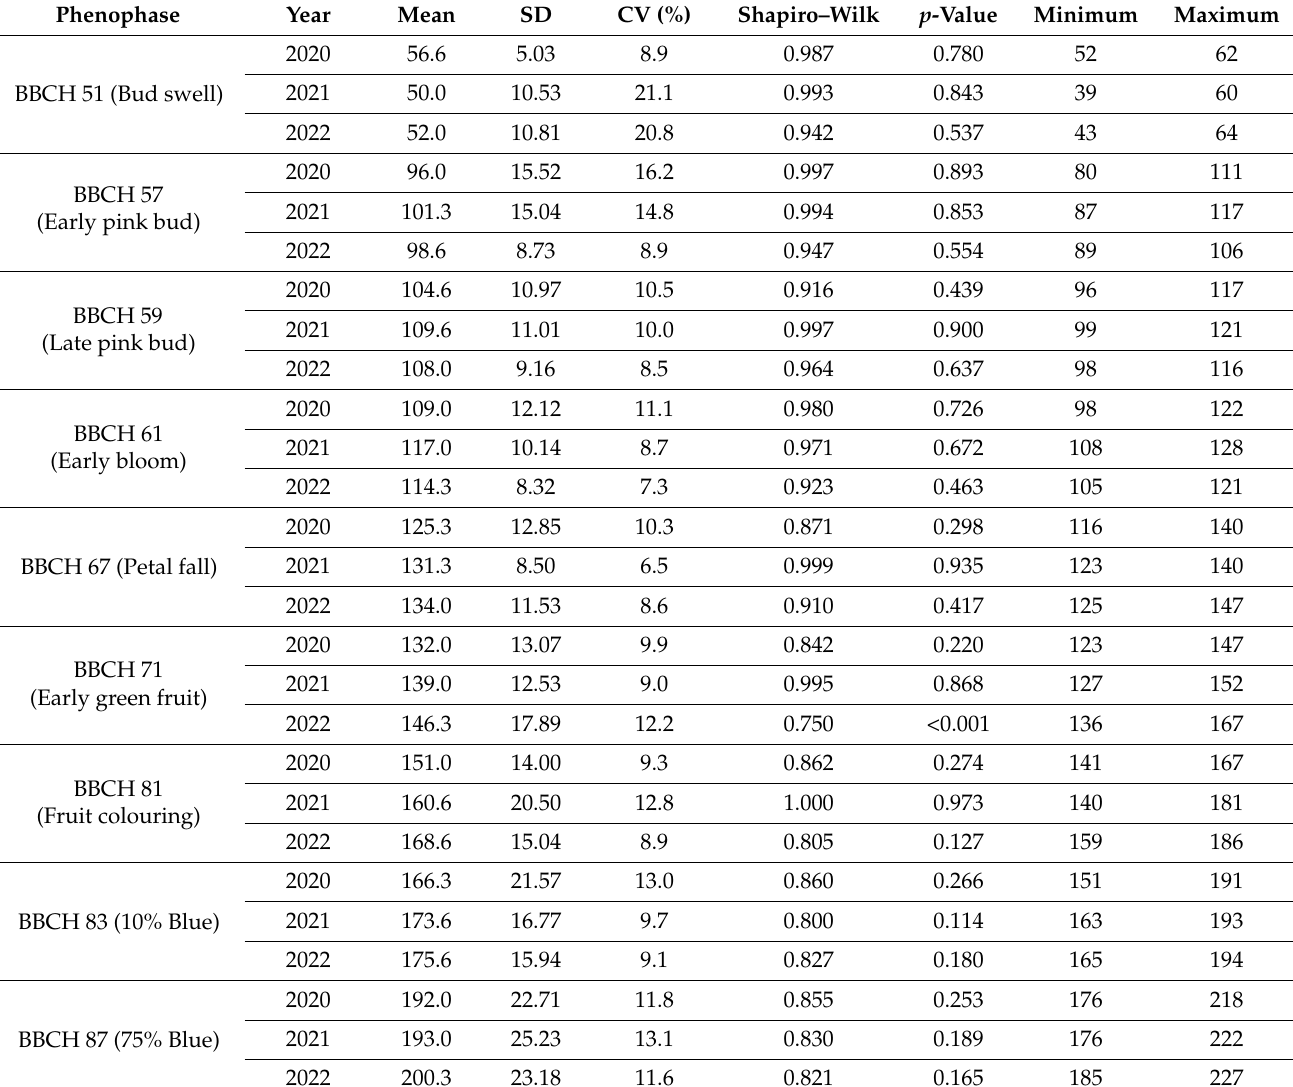
Table 2. Descriptive statistics regarding the influence of experimental year on generative phenophases of blueberry cultivated in the low hilly area of Banat